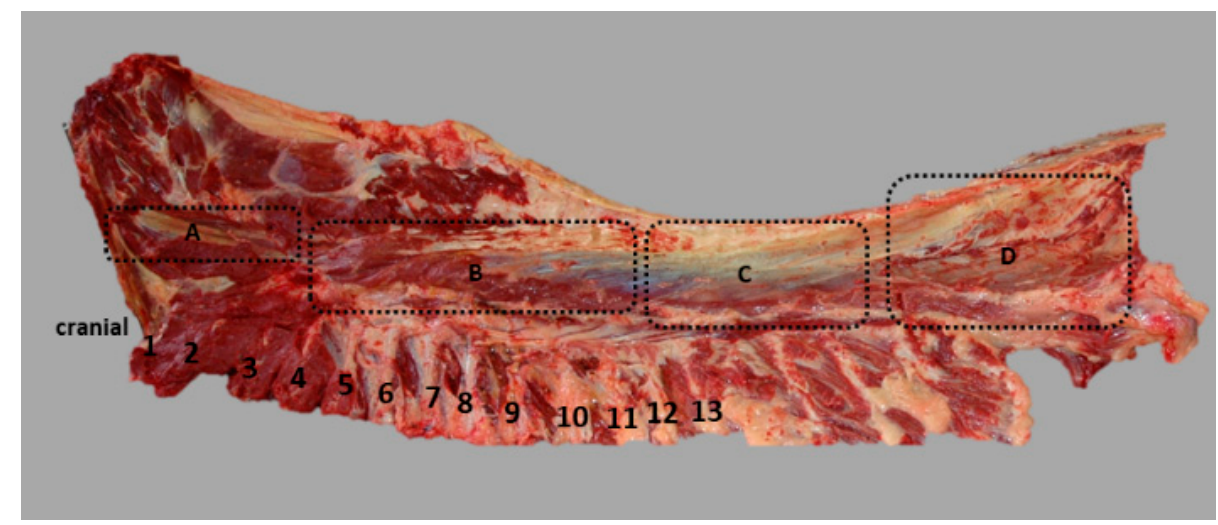
Figure 2. Left lateral view of a freshly dissected horse back. Neck region removed cranial to the 6th vertebra, thoracic and abdominal wall reduced to most dorsal aspects, hind limbs exarticulated and tail removed. The thoracolumbar longissimus dorsi muscle (LG) is exposed after removing skin, fat and overlying muscles. Ribs are numbered cranial to caudal (numbers 1–13). The thoracolumbar LG was divided macroscopically into compartments A – D . Compartment A describes the most cranial part of the muscle inserted at the last cervical vertebrae, followed by compartment B which overlaps compartment A in the cranial part at the height of the 4th rib. The caudal part of compartment B reaches to the height of the 13th rib. Compartment C comes right behind compartment B and reaches from the height of the 13th rib to the impression of the removed Musculus gluteus medius. Compartment C is followed by compartment D , which is the most caudal part of the muscle, becoming visible after removing the gluteus medius muscle. Compartment D is the most caudal part of the muscle that is in close contact with the gluteus medius muscle, as it inserts at the aponeurosis of the LG. It has a slim dorsal muscle belly that originates at the dorsal processes of the sacrum and a ventral flat portion, which runs from the iliac crest.